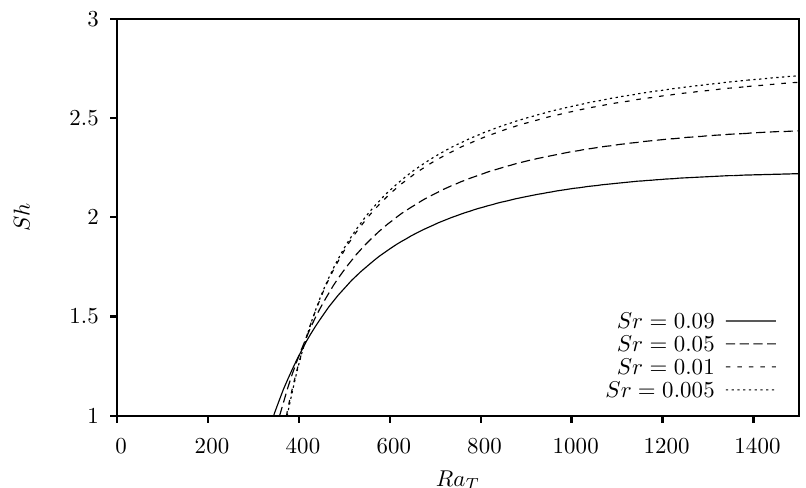
Figure 14. Variation of Sh with Ra T for steady nonlinear stability: effects of Sr for Du = 0.05, Ras = 250, R i = 1, Le = 1.